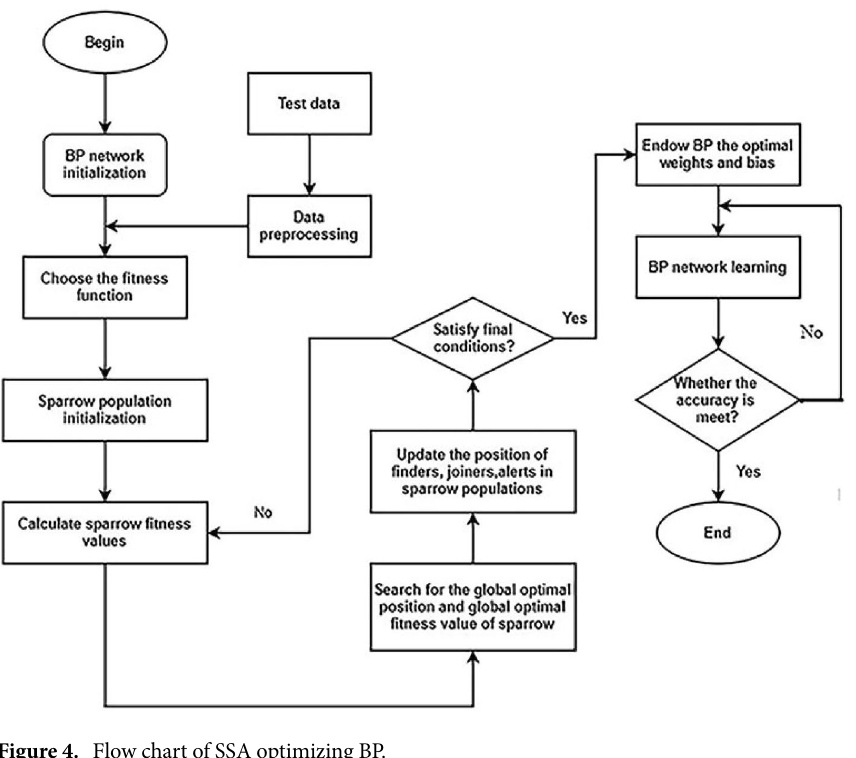
Figure 4. Flow chart of SSA optimizing BP.